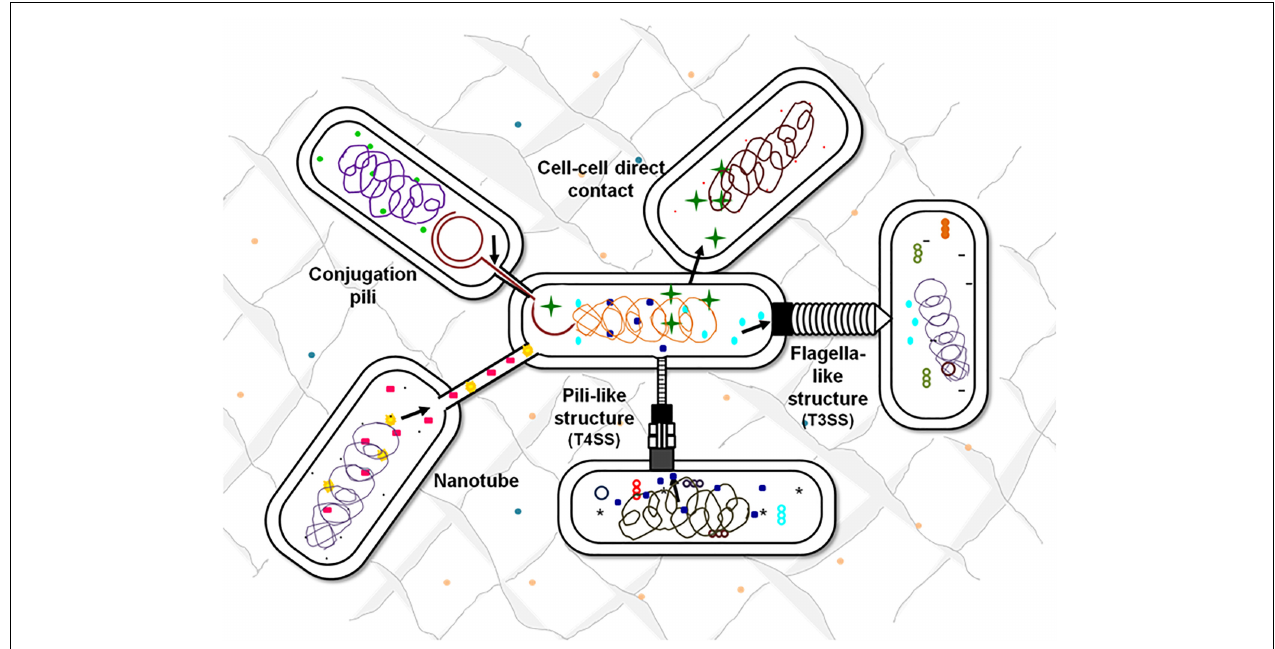
FIGURE 3 | Contact-dependent signaling mechanisms. Effector molecules can be transferred from one cell to another using contact-mediated signaling methods. Exchange of metabolites can be either through the surface appendages or can be even by direct surface contact. Flagella-like structures assembled by T3SSs, pili-based structures by T4SSs, intercellular nanotubes, and conjugation pili are the appendages-based methods that facilitate the exchange of cellular